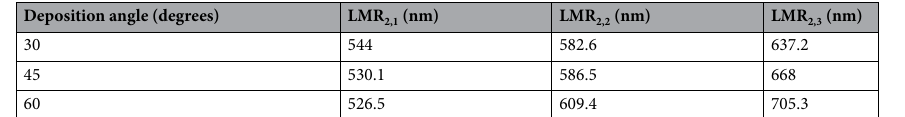
Table 1. Wavelengths of the LMRs generated by coatings with a gradient in thickness induced by different deposition angles.